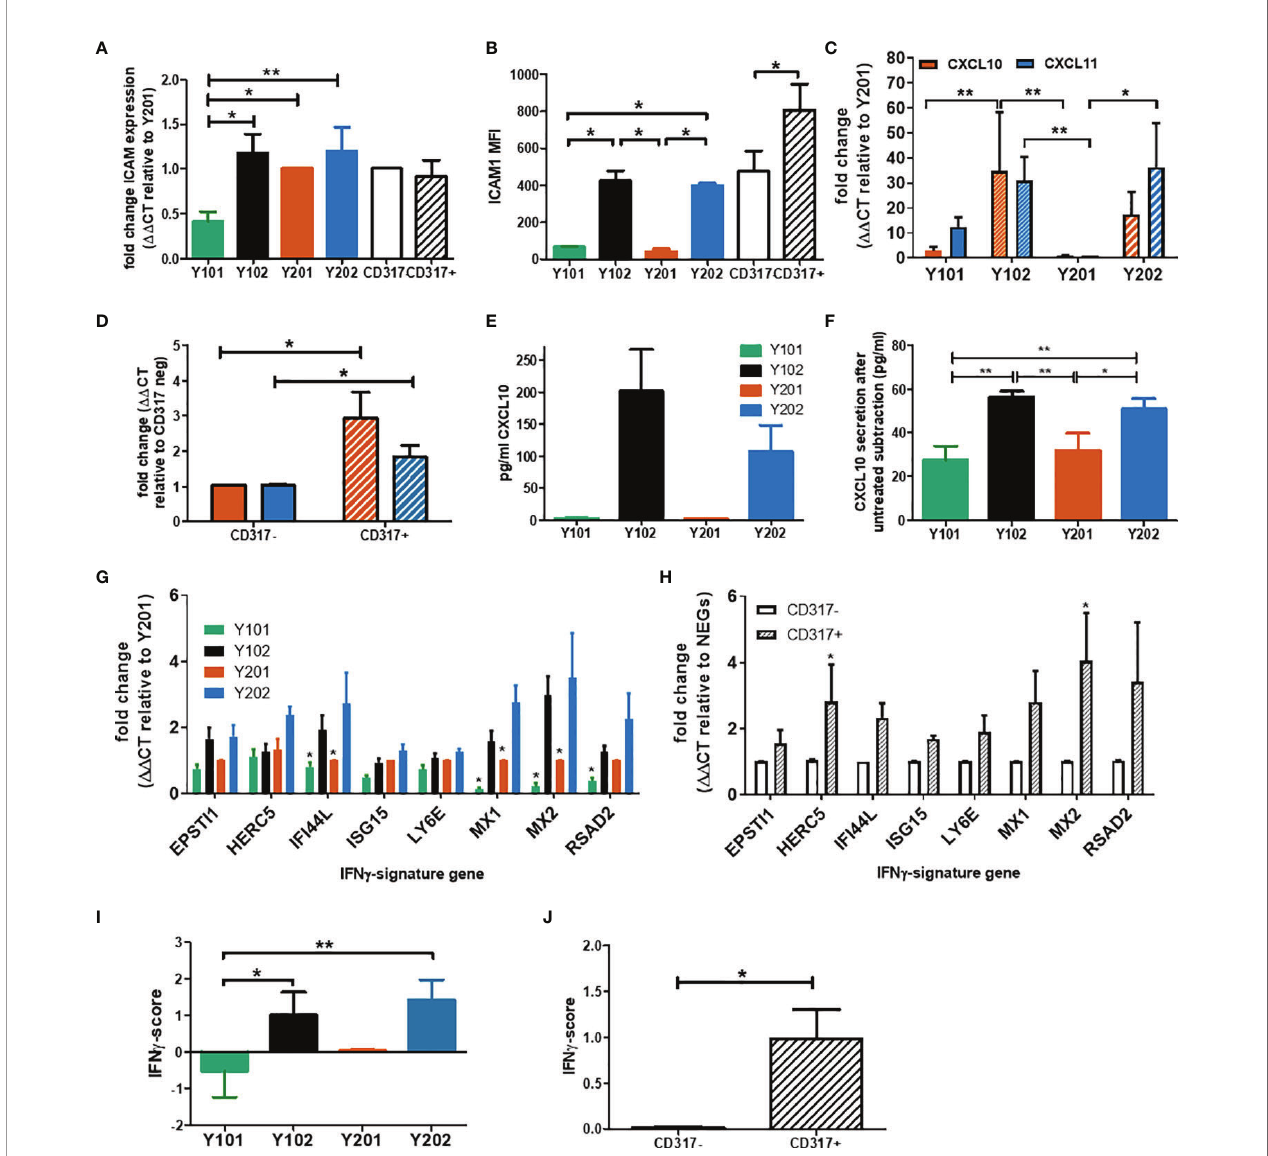
FIGURE 2 | Examination of the immune pro fi le of CD317 pos MSCs. (A) Comparative mRNA expression of ICAM-1 in MSC lines and primary cells sorted by CD317 expression (RNA was extracted from 3 different donors or 5 cell line passages; qPCR performed in triplicate, mean shown ± SEM). (B) Mean fl uorescence intensity of ICAM-1 expression on the cell surface of MSC lines and primary MSCs differentially gated by CD317 staining (MSCs from 5 different donors or 4 different passages of MSC lines were stained for fl ow cytometry, mean shown ± SEM). (C)/(D) Comparative (mean ± SEM) mRNA expression of CXCL10 (red) and CXCL11 (blue) in MSC lines/primary MSCs sorted for CD317 expression (RNA was extracted from 7 different donors/7 different cell passages; experiments were performed in triplicate). (E/F) CXCL10 secretion by MSC lines prior to IFN- g priming and after priming with baseline (unprimed) secretion subtracted (mean ± SEM, n=2). (G/H) Comparative mRNA expression of 8 IFN- g signature genes in MSC lines/primary MSCs sorted by CD317 expression (RNA was extracted from 5 different donors/5 different cell passages; experiments were performed in triplicate, mean shown ± SEM). (I)/(J) IFN- g score for MSC lines/primary MSCs sorted by CD317 expression (n=5)*/** = signi fi cance at P<0.05/0.01 using an appropriate statistical